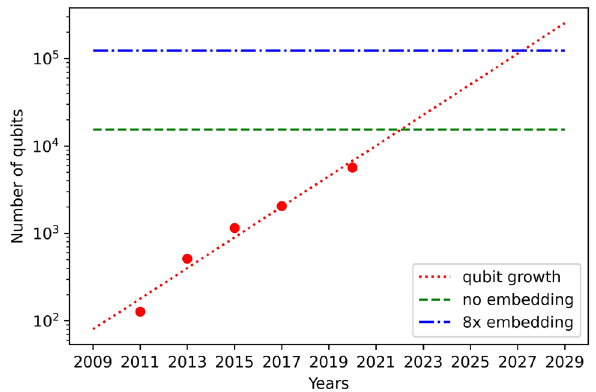
Figure 6. Progress of required and available qubits for solving a H-SEARCH problem. The red-dotted curve is a regression line based on actual number of qubits (shown as red circles) produced by D-Wave 38–42 . The linear curve in semi-logarithmic plot indicates that the number of qubits is doubled every two years. The blue (dash-dot) line at the top shows required number of qubits in finding 668 order H-matrix for each of a given { X ∗ , Y ∗ , Z ∗ , W ∗ } by assuming an embedding factor of 8, whereas the green (dashed) curve is the required number of qubits with no embedding factor, meaning an ideal complete graph connections among the qubits are